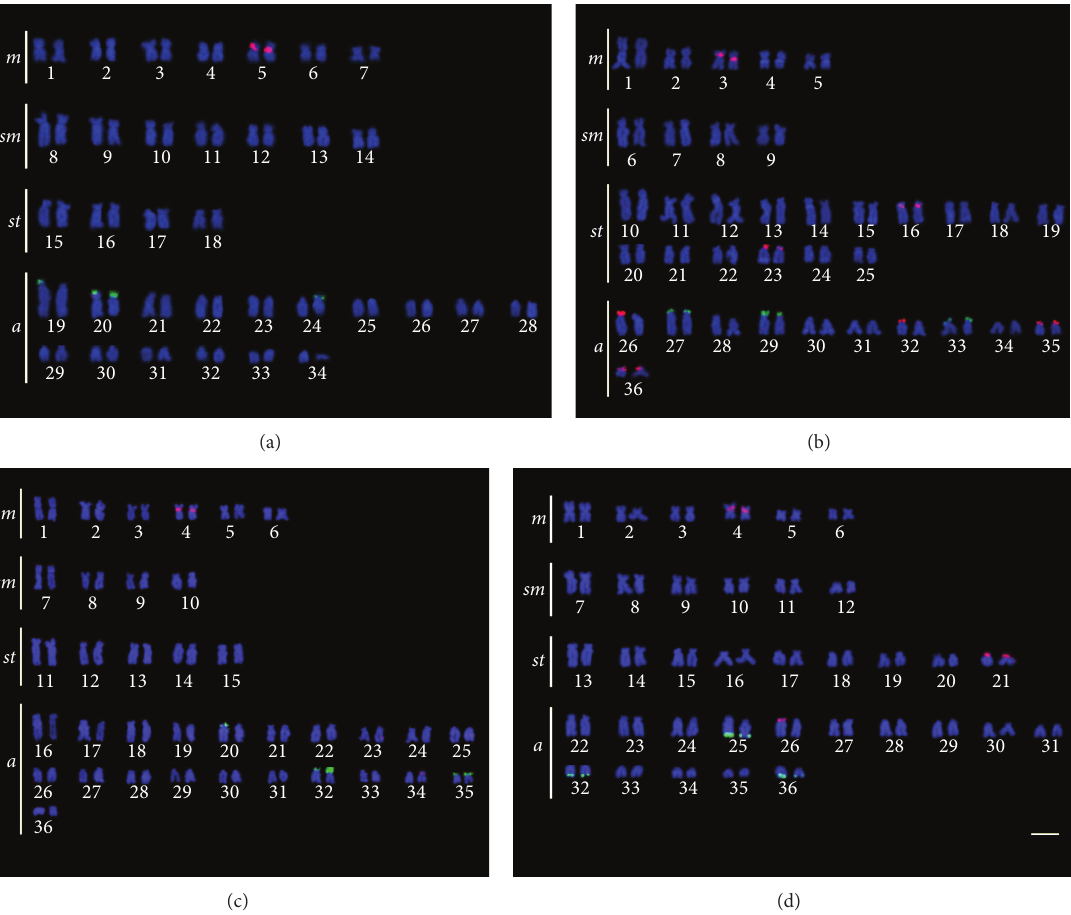
Figure2:DoubleFISHkaryotypeswith5SrDNAprobes(rhodamine,red)and18SrDNAprobes(FITC,green)of(a) Hypostomusancistroides ; (b) Hypostomus hermanni ; (c) Hypostomus regani ; (d) Hypostomus strigaticeps . The bar represents 5 𝜇